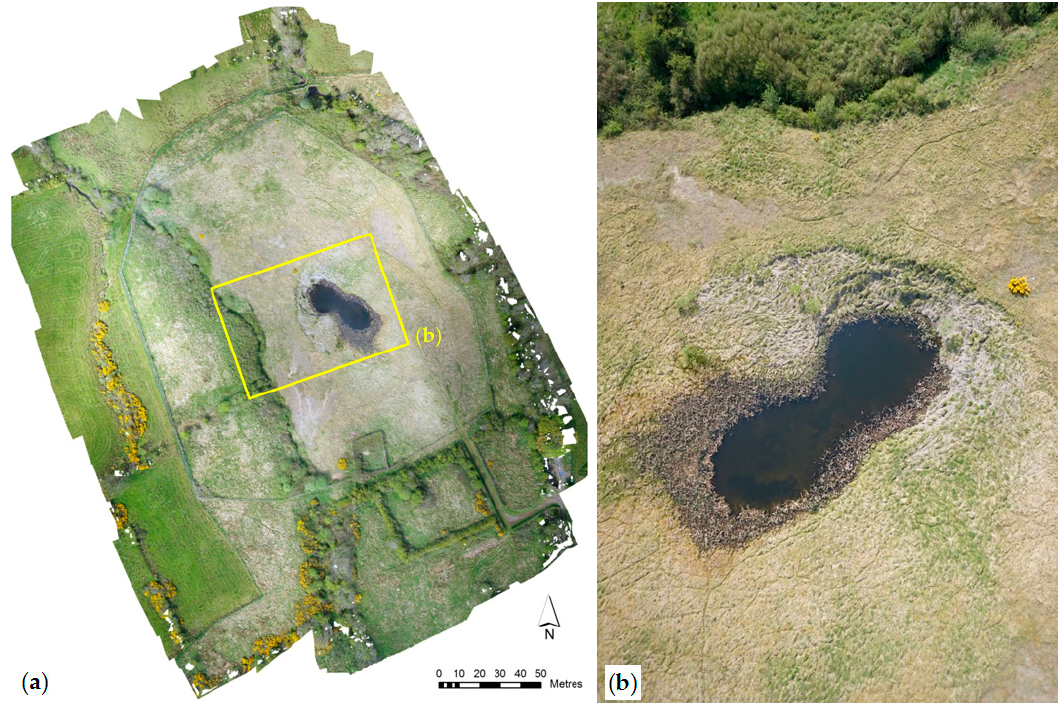
Figure 7. ( a ) Small Unmanned Aerial Vehicle (SUAV)-derived Very High Resolution (VHR) ortho- photograph and ( b ) close-up of the Maiden Mount salt mine collapse, derived based on data